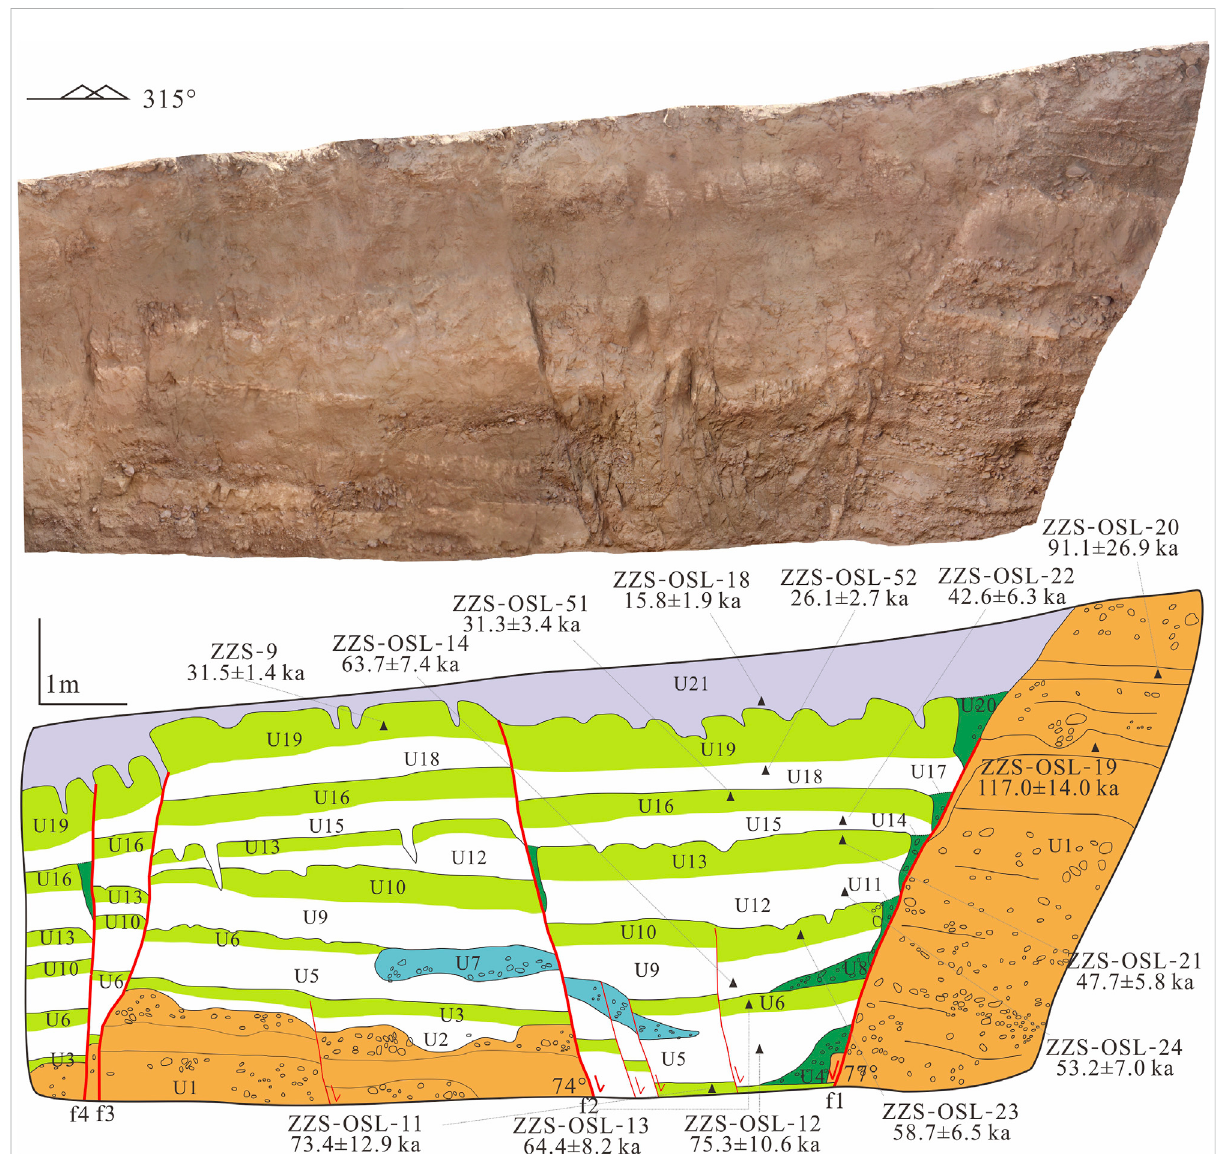
FIGURE 7 Photomosaic and corresponding log map of trench 3. Active faults and sample results are shown in the trench log. Colors in the same color scheme present similar sedimentary units; for example, the grass greenrepresents different buried paleosols and the dark green represents colluvial wedges or fi lling